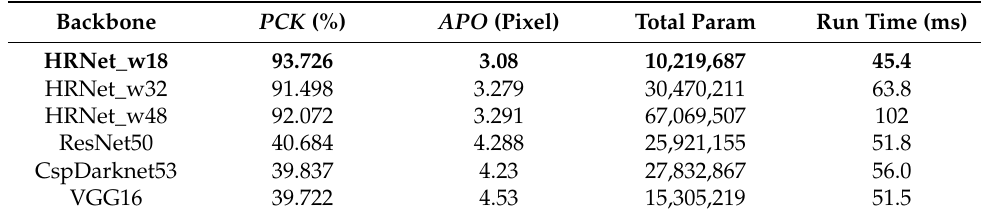
Table 3. Comparison of model prediction performance by different backbone networks.